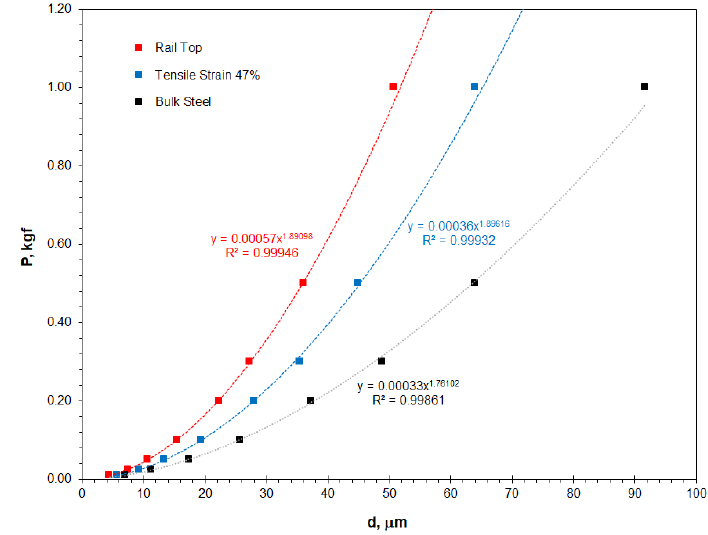
Figure 5. Meyer’s P~d profiles of the Hadfield steel, showing effect of plastic strain on the power law relationship. relationship.